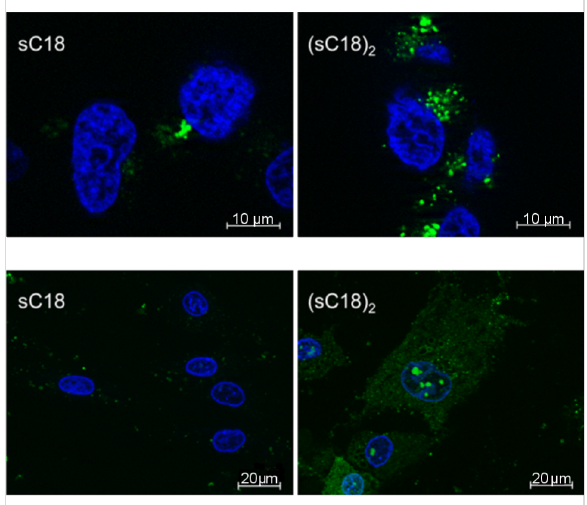
Figure 2: Top: Fluorescence microscopic images of unfixed HEK-293 cells after 30 min incubation with 1 µM CF-sC18 and CF-(sC18) 2 . Bottom: Fluorescence microscopic images of unfixed hADSC after 1 h incubation with 25 µM CF-sC18 and CF-(sC18) 2 . Blue: Hoechst33342 nuclear dye, green: carboxyfluorescein-labeled peptides. Images taken with a 63× oil immersion objective.